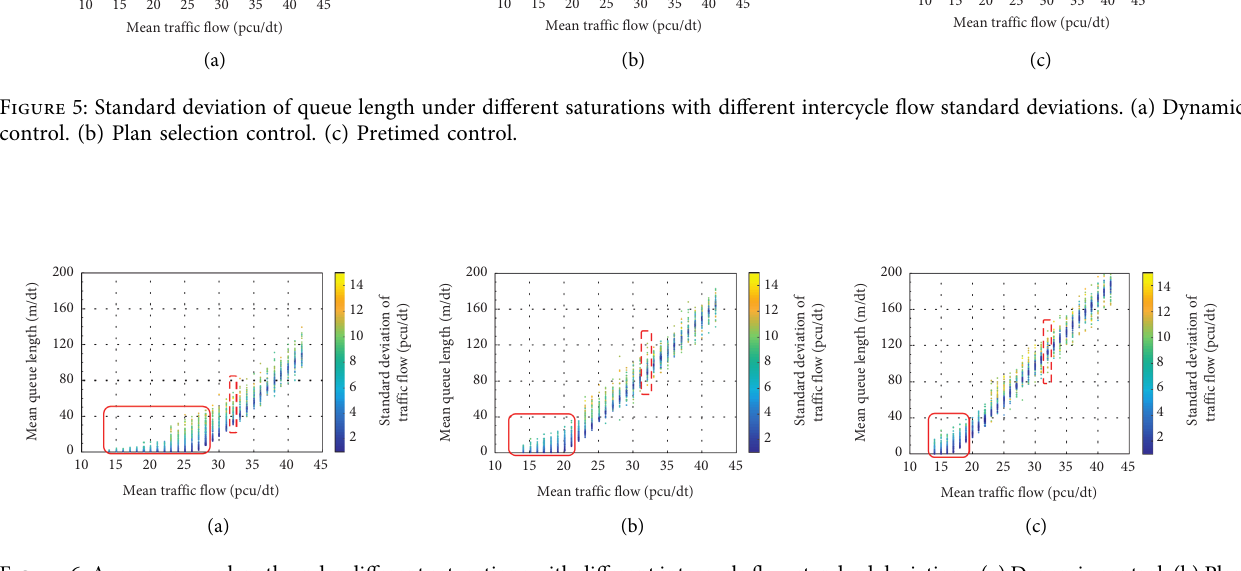
Figure 6: Average queue length under different saturations with different intercycle flow standard deviations. (a) Dynamic control. (b) Plan selection control. (c) Pretimed